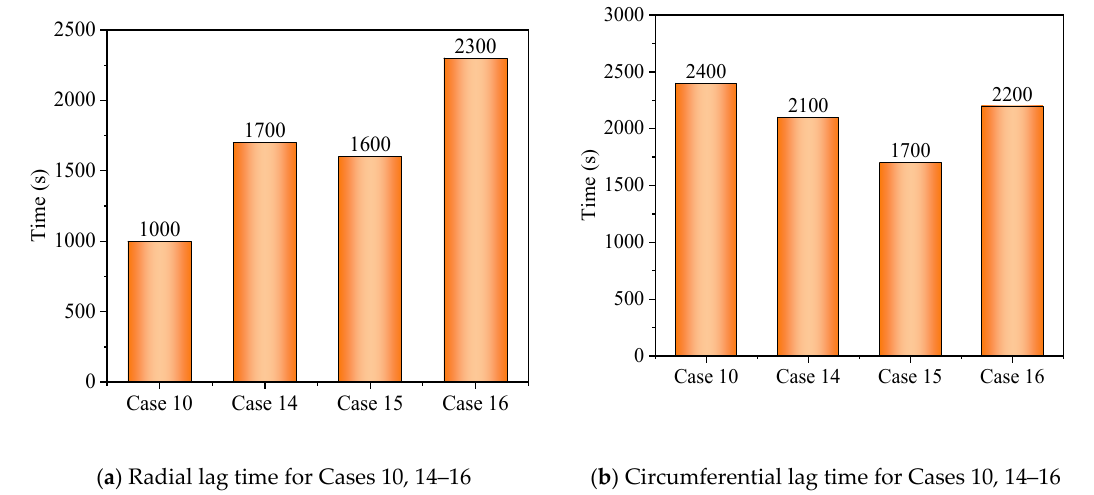
Figure 22. Thermal penetration and thermal uniformity for Cases 10, 14 – 16.